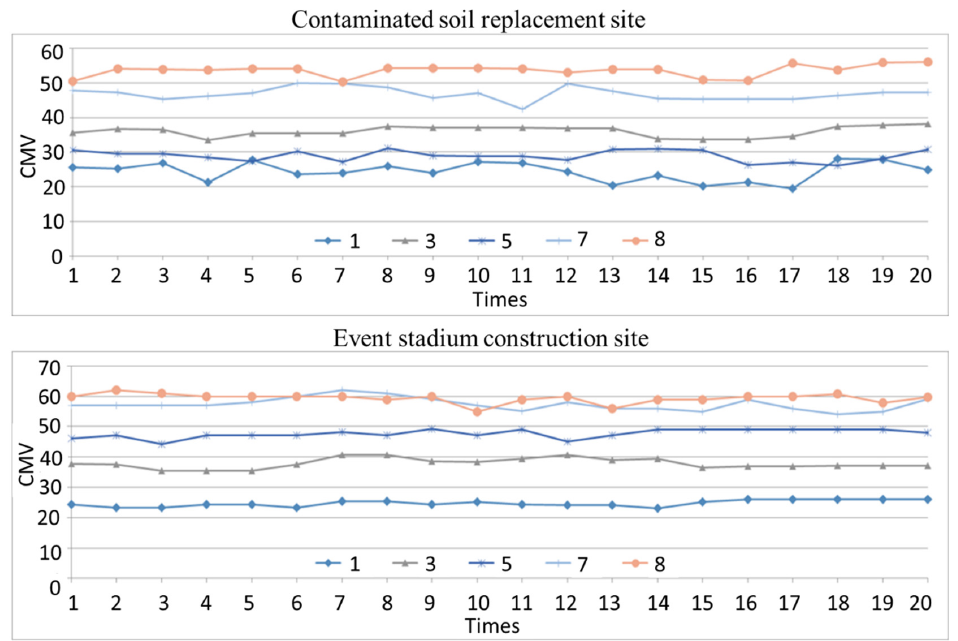
Figure 8. CMV data recorded during the compaction operation.